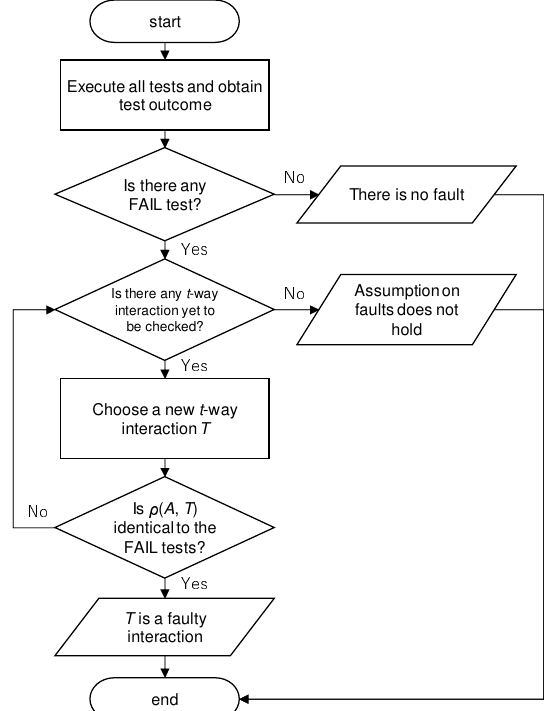
Figure 1. The process of locating a fault interaction using a ( ¯ 1, t ) -LA A . ρ ( A , T ) is the rows